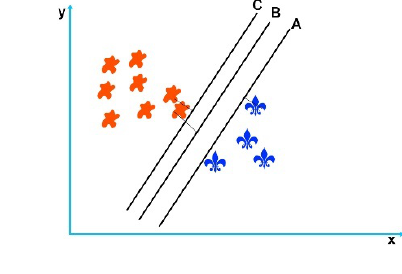
Figure 3. SVM with